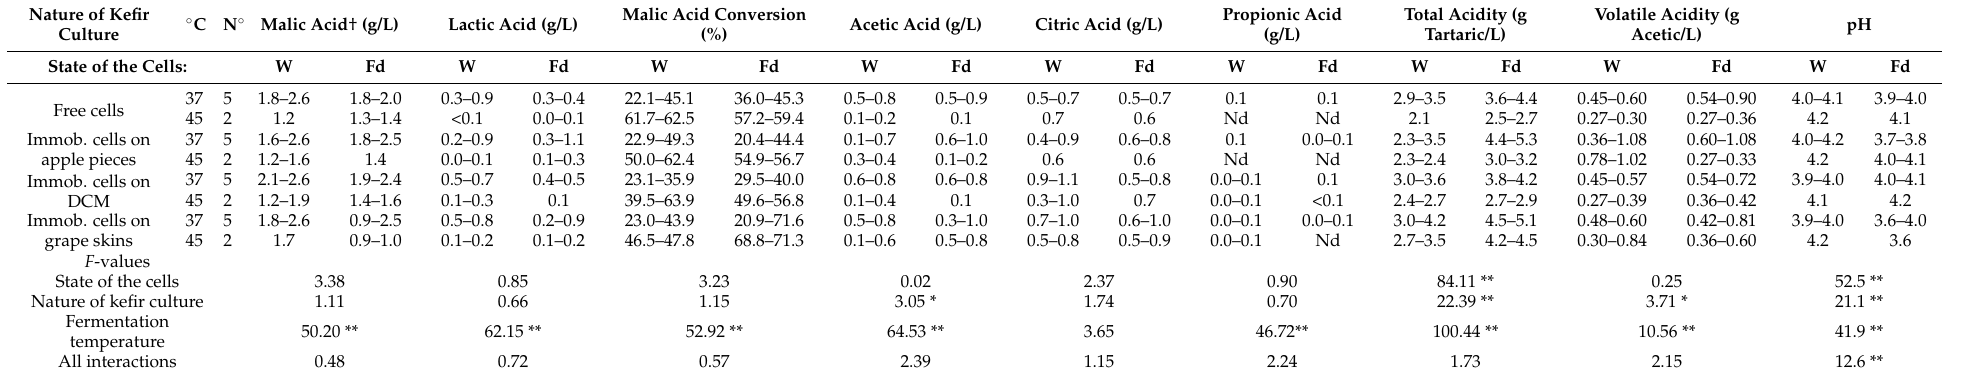
Table 2. Effect of cell immobilization, freeze-drying, and high temperature on the profile of organic acids and enological parameters during semi-dry and sweet low alcohol wine-making by repeated batch fermentations using kefir